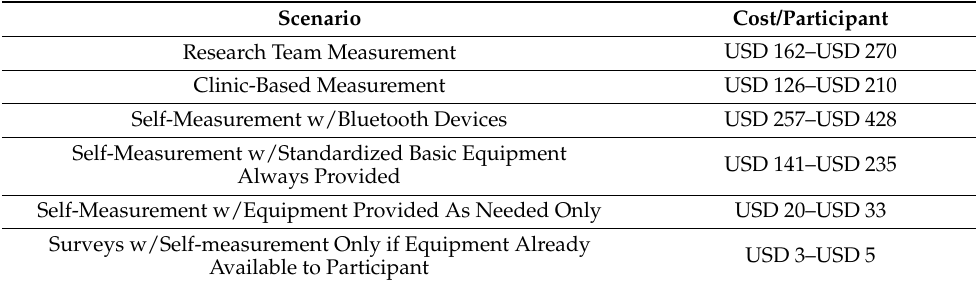
Table 4. Per participant data collection costs under each